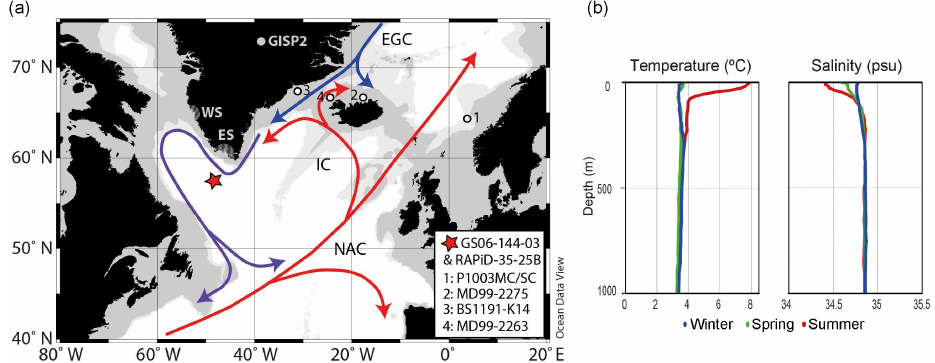
Figure 1. (a) Location of multicore GS06-144-03 (red star) and other sites in the northern North Atlantic whose records have been used to support the discussion proposed in this work. General North Atlantic circulation is shown according to Schmitz and McCartney (1993). The location of Norse settlements in Greenland is shaded and indicated with ES (eastern settlement) and WS (western settlement). (b) Temperature and salinity profiles of the first 1000m at site GS06-144-03 obtained through Ocean Data View (https://odv.awi.de/) from the World Ocean Atlas 2013 (Locarnini et al., 2013; Zweng et al.,